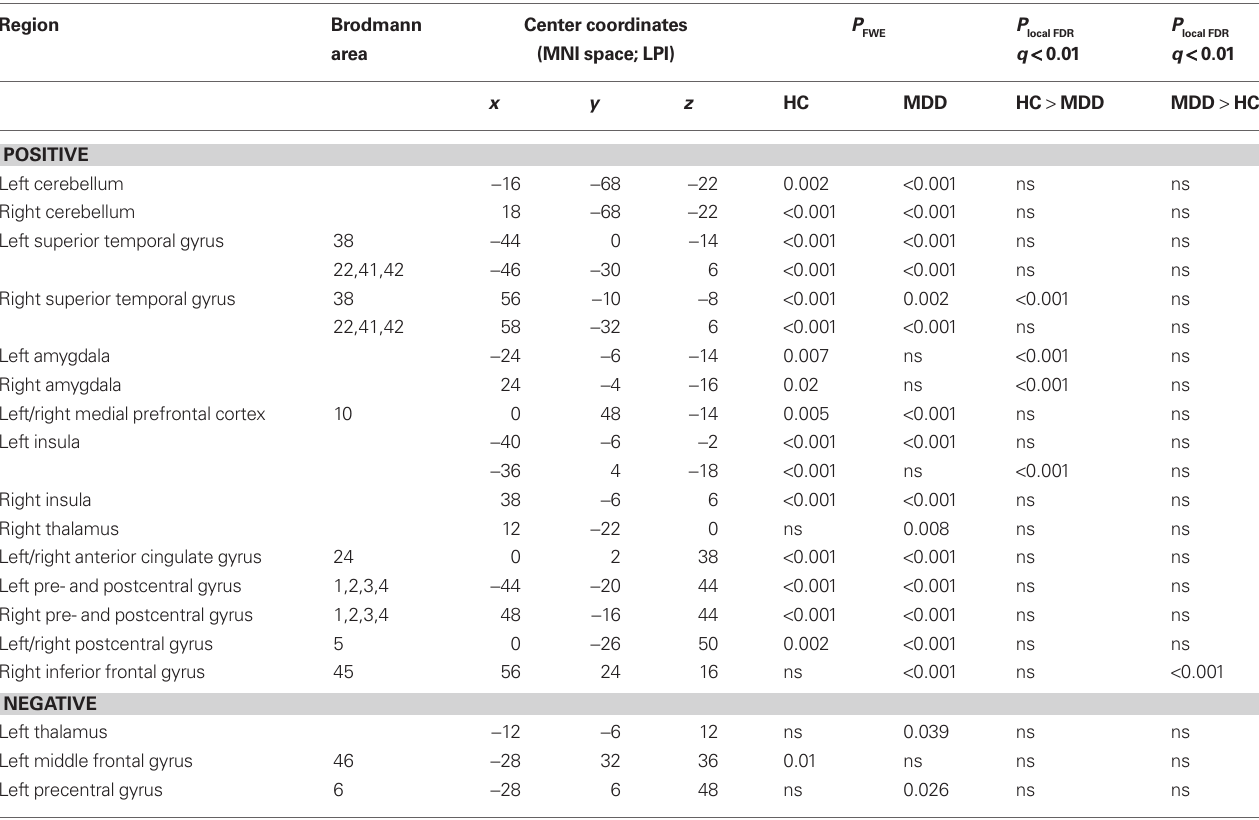
Table 2 | rSN 12 characteristics and